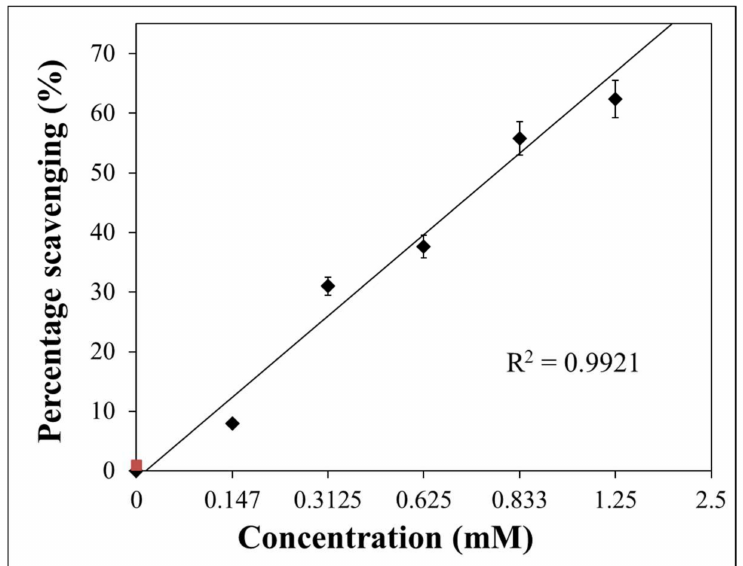
Figure 7. Percentage inhibition for grape skin extract in ABTS + scavenging activity.